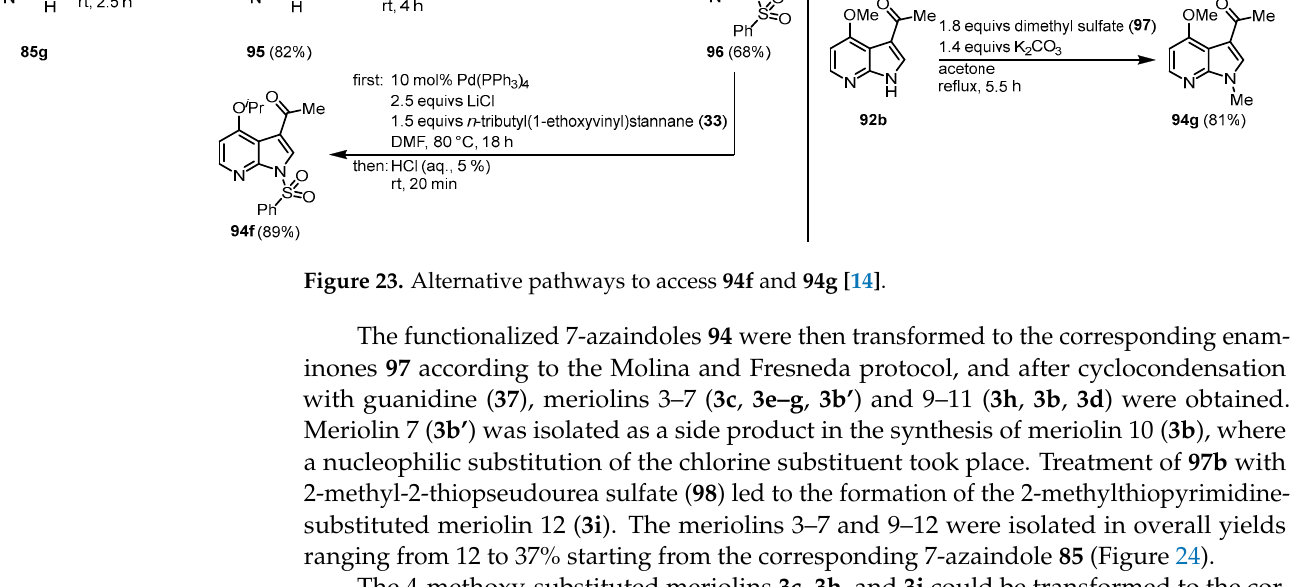
Figure 24. Synthesis of meriolins 3–7 and 9–12 by Joseph and Meijer [14]. The 4-methoxy-substituted meriolins 3c , 3h , and 3j could be transformed to the corresponding 4-hydroxy-substituted meriolins 2 ( 3k , 26% overall yield), 8 ( 3l , 31% overall yield), and 13 ( 3m , 22% overall yield) by O -demethylation with hydrobromic acid in acetic acid (Figure 25) [14,16].